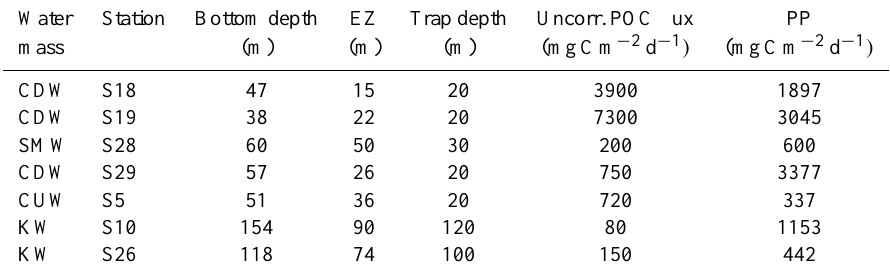
Table 1. Parameters of bottom depth, euphotic zone (EZ) depth, uncorrected POC flux, and primary production (PP) in the ECS. Water Station Bottom depth EZ Trap depth Uncorr. POC flux PP